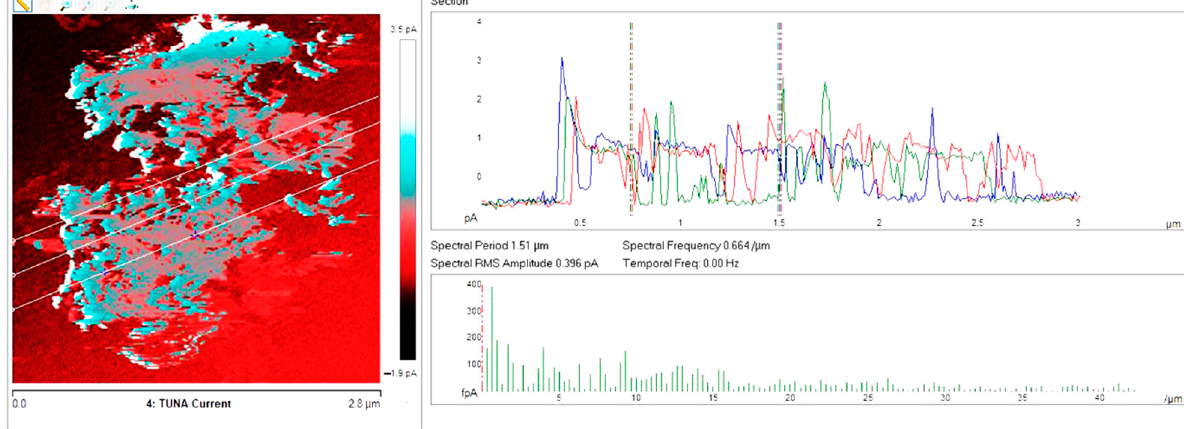
Figure 12 . From left to right, TUNA Current picture and current variation profile of the sample TCTBD+0.5%MWCNT-b.